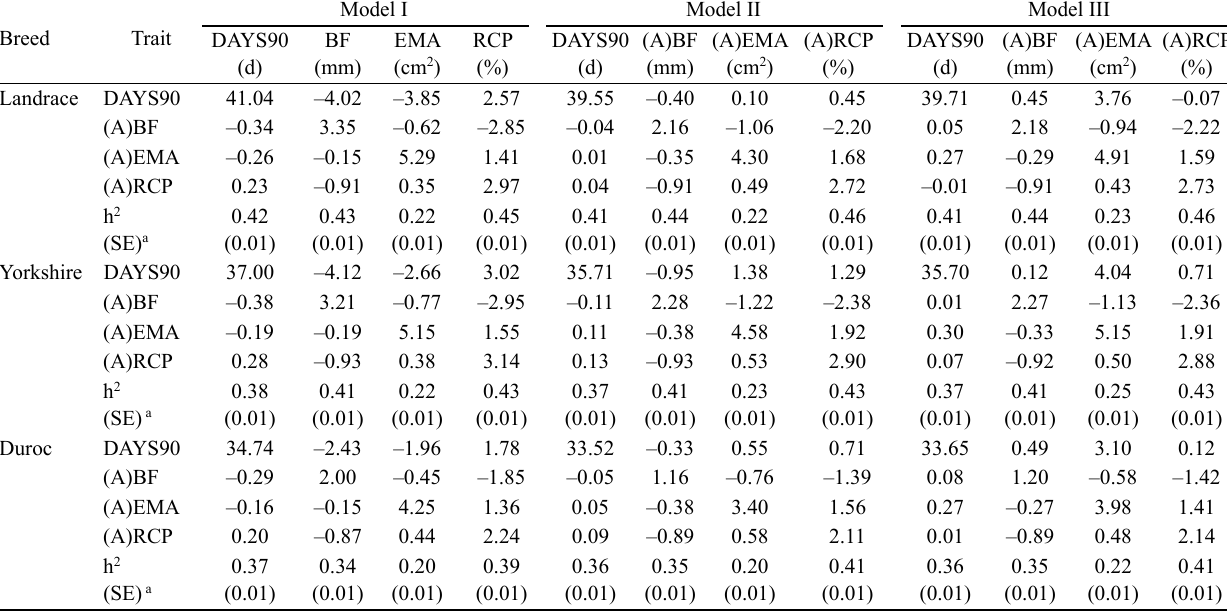
Table 4. Genetic variances (diagonals), covariances (above the diagonals), heritability estimates (h 2 ), and genetic correlation coefficients (below the diagonals) of growth and ultrasound measures by breeds Breed Trait Landrace DAYS90